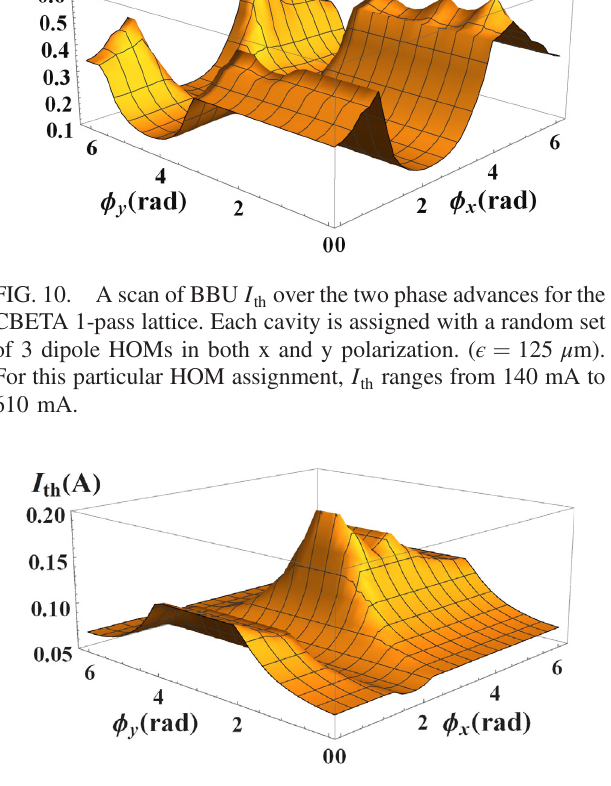
FIG. 11. A scan of BBU I over the two phase advances for the th CBETA 4-pass lattice. Each cavity is assigned with a random set of 3 dipole HOMs in both x and y polarization. ( ϵ ¼ 125 μ m). For this particular HOM assignment, I ranges from 61 mA to th 193 mA.